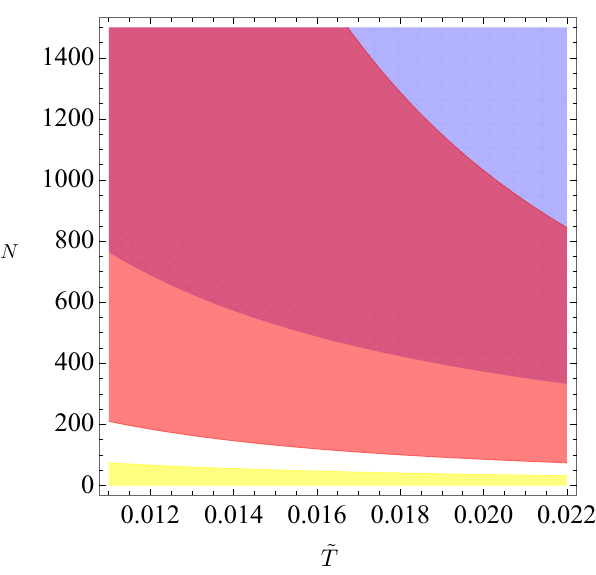
Figure 1 . Allowed regions in ( ~ T; N ) plot. Blue region shows that for H shows (2.6) with s = 0 : 1. We also show the region (Yellow) where the heat capacity is negative and thus the spacetime is thermodynamically